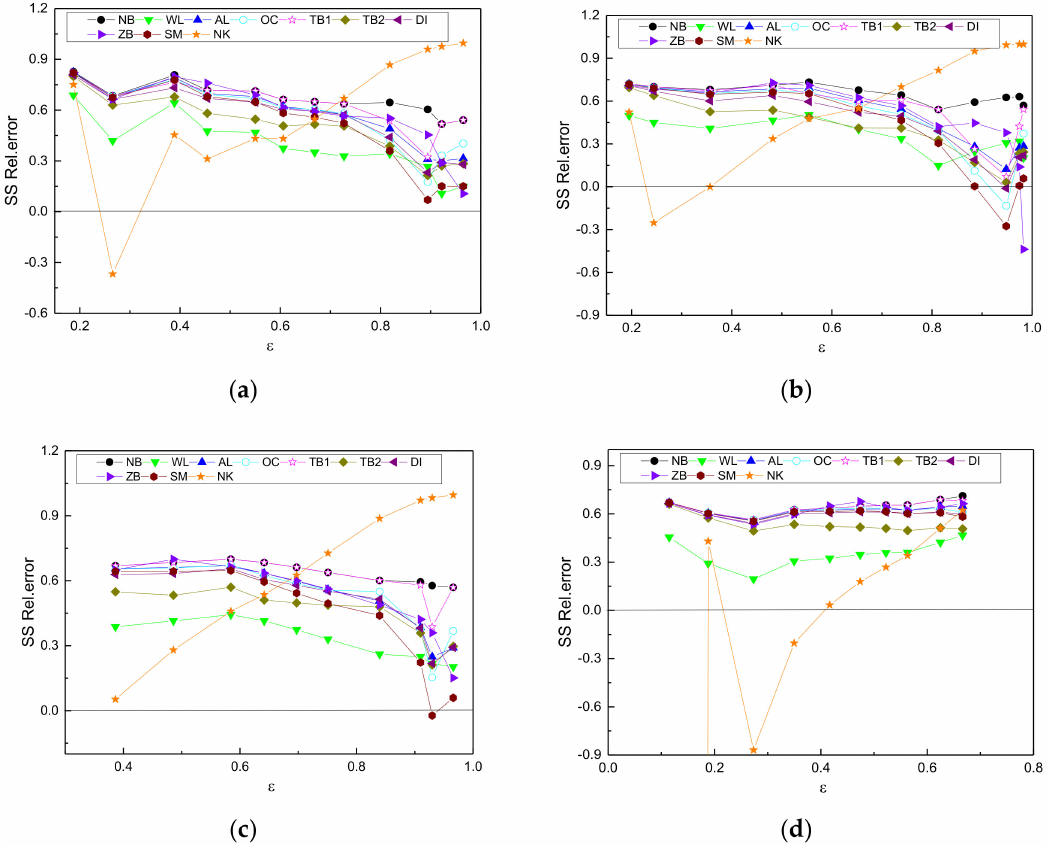
Figure 8. Comparison of relative errors in estimating fatigue life by frequency-domain method (spring steel): ( a ) Single peak spectrum; ( b ) bimodal spectrum; ( c ) multi-peak spectrum; ( d ) band-limited white noise